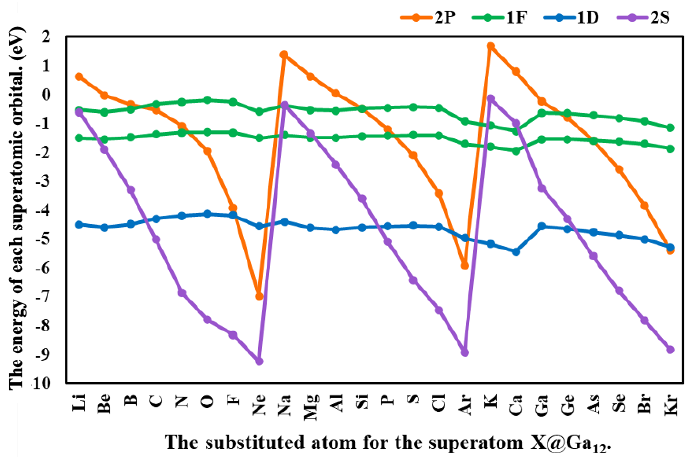
Figure 5. Energy levels of the 2P (purple), 1F (green), 1D (blue), and 2S (orange) superatomic-like